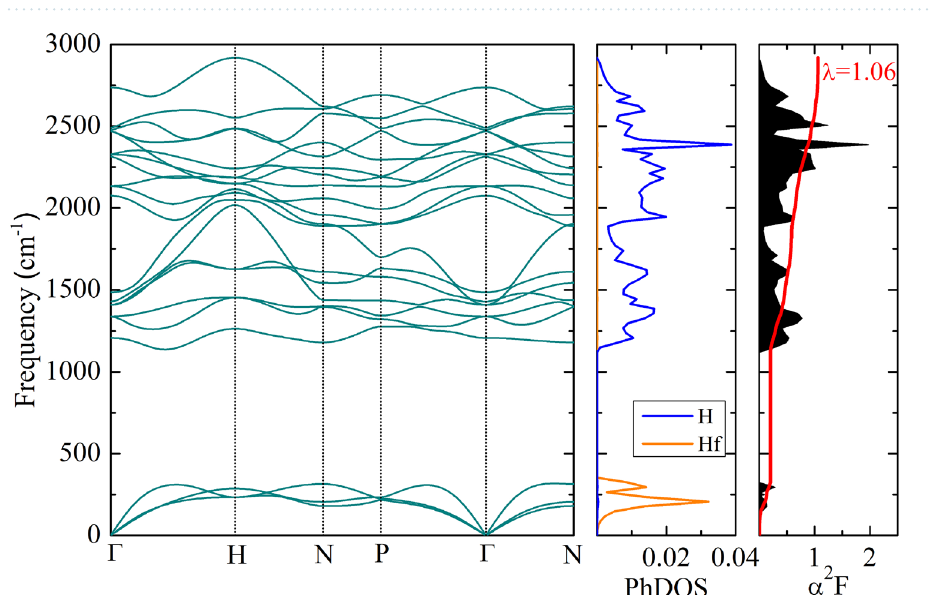
Figure 3. (Left) The calculated phonon dispersion at 600 GPa. (middle) The calculated projected phonon density of states at 600 GPa. (rigth) The Eliashberg spectral function and the integrating of lambda at 600